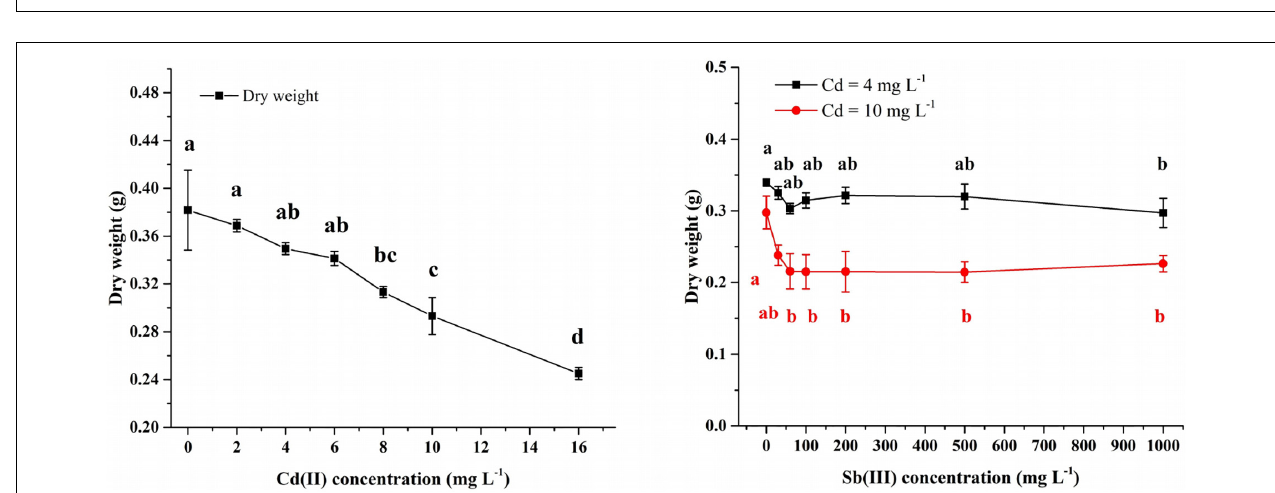
FIGURE 2 | Phylogenetic tree based on 16S rRNA gene sequence. The bar represents evolutionary distance of 0.005.